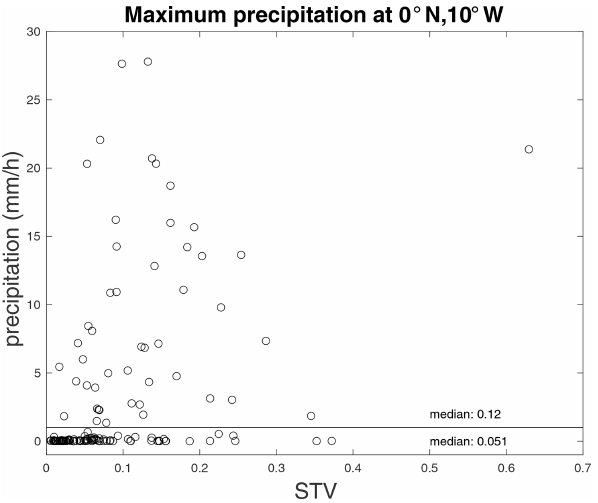
Figure 12. Median model SFV vs. model STV at each mooring location. Each symbol represents one mooring. The light line has a slope of 1. The dashed black line is a least-squares fit to the data shown, with the slope indicated in the top